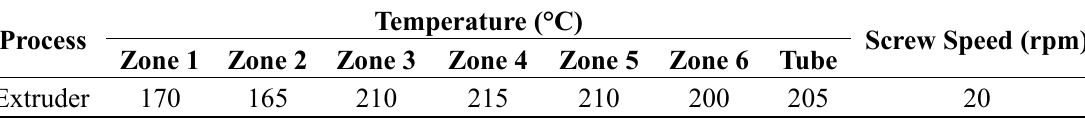
Figure 1. Schematic of extrusion and solid-state drawing pilot-production line. Table 1. Default extrusion